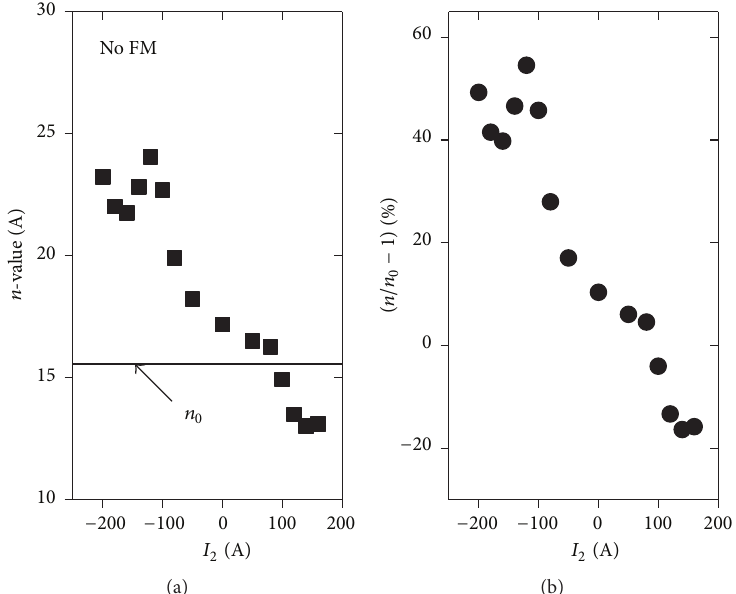
Figure 6: (a) 𝑛 -value versus the applied current to the neighboring tapes and (b) increase of 𝑛 with respect to the neighboring current for three-layer stacked conductor without